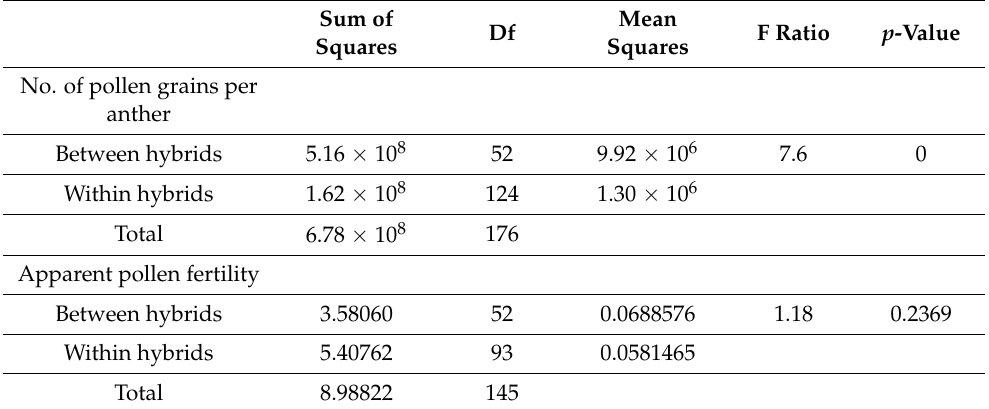
Table 2. ANOVA for number of pollen grains per anther and apparent pollen fertility. Sum of Mean Df F Ratio p -Value Squares Squares No. of pollen grains per anther Between hybrids 5.16 × 10 8 0 Within hybrids 176 Apparent pollen fertility Between hybrids 3.58060 0.0688576 0.2369 Within hybrids 5.40762 93 Total